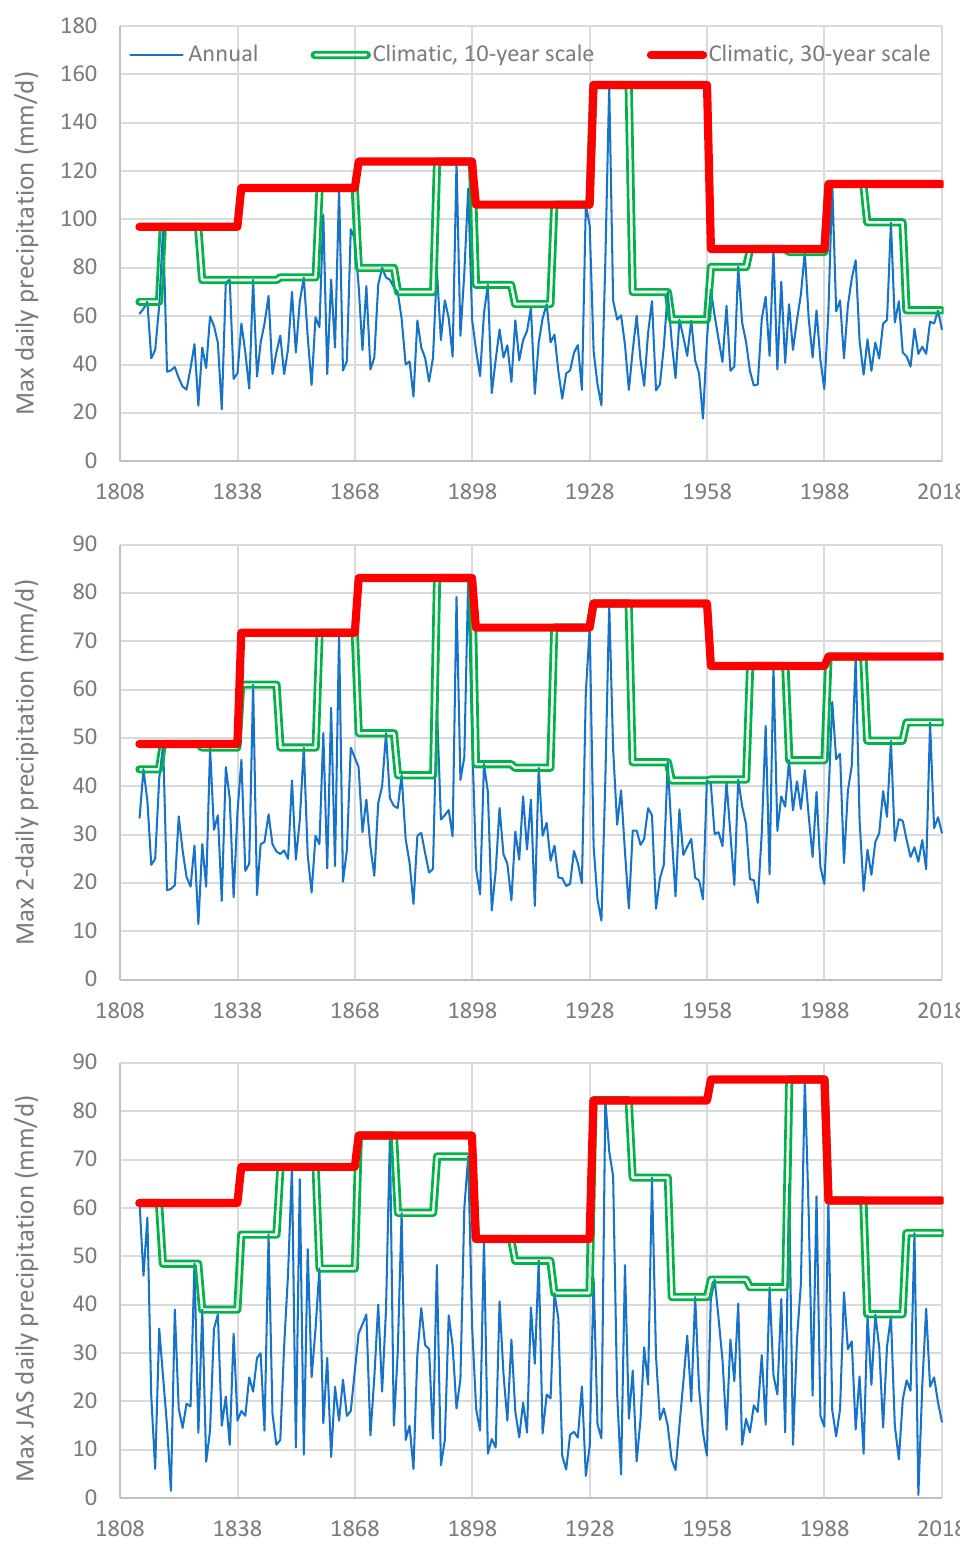
Figure 6. ( upper ) Evolution of the maximum daily precipitation in Bologna, as a climatic element, seen at the annual and the climatic time scales of 10 and 30 years; ( middle ) as in the upper panel but for the maximum two-daily precipitation; ( lower ) as in upper panel but for a time window of the three summer months, July, August, September (JAS).